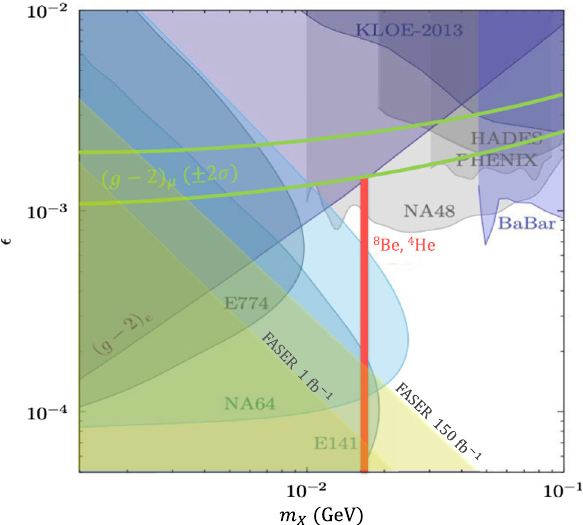
Fig. 30 Protophobic gauge boson parameter space, where m X is the massofthe X boson,and (cid:7) isitselectroncoupling.Thefigureisadapted from Ref. [15] with a few supplementary contours. The 8 Be and 4 He anomalies may be resolved in the red region [8,57]. Between the green contours, assuming (cid:7) μ = (cid:7) e , the X boson also reduces the current 4 . 2 σ discrepancy in ( g − 2 ) μ to 2 σ . The blue and purple regions are excluded by the indicated experiments; the gray NA48 region is not applicable to protophobic gauge bosons. FASER will be sensitive to the yellow regions with the LHC Run 3 integrated luminosities indicated [110]